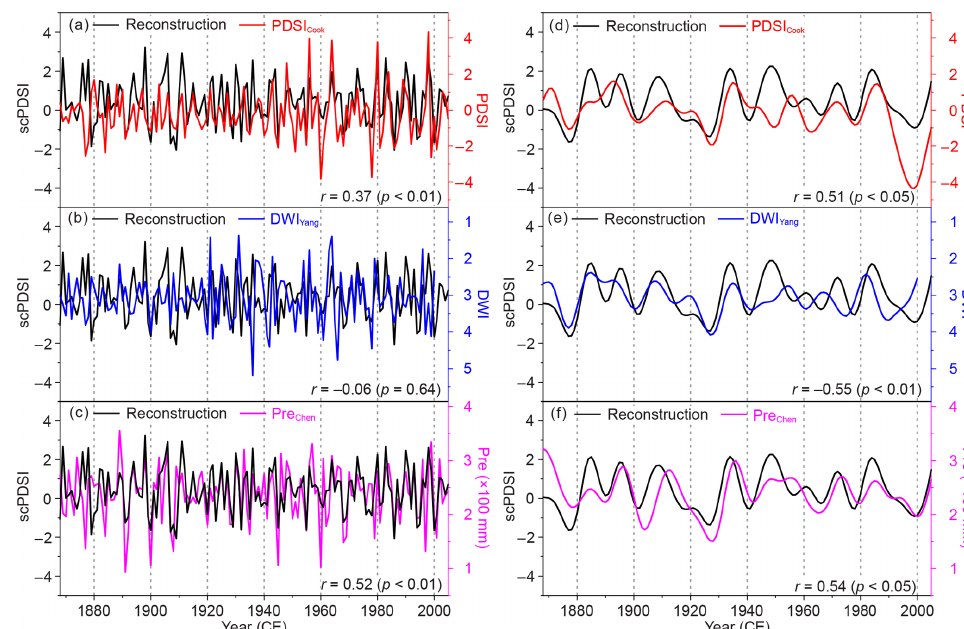
Figure 7. Comparison of the reconstructed MJJ scPDSI (black line) with other hydroclimatic reconstructions in adjacent regions on the interannual (a, b, c) and decadal and longer timescales (d, e, f) . The referenced reconstructions are (a , d) June–August PDSI of MADA no. 370 grid point (Cook et al., 2010), (b, e) reversed DWI (Yang et al., 2013), and (c, f) TRW-based April–June precipitation (Pre) reconstruction (Chen et al., 2016b). The interannual and decadal and longer fluctuations were separated using the adaptive 10-point Butterworth low-pass filter with 0.1 cutoff frequency (Mann, 2008). r represents the Pearson correlation coefficient between the reconstructed MJJ scPDSI and other hydroclimatic reconstruction over their common period. The significance level for all correlation coefficients was tested using the Monte Carlo method (Efron and Tibshirani, 1986; Macias-Fauria et al., 2012).